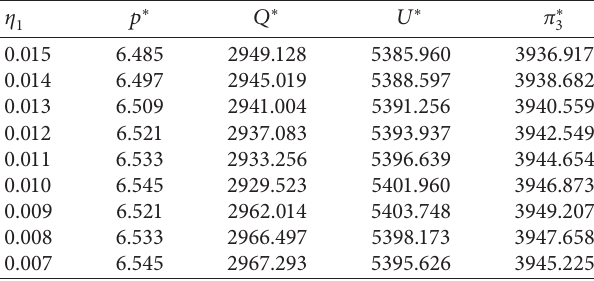
Table 3: Impact of the deterioration rate on retailer’s decisions.